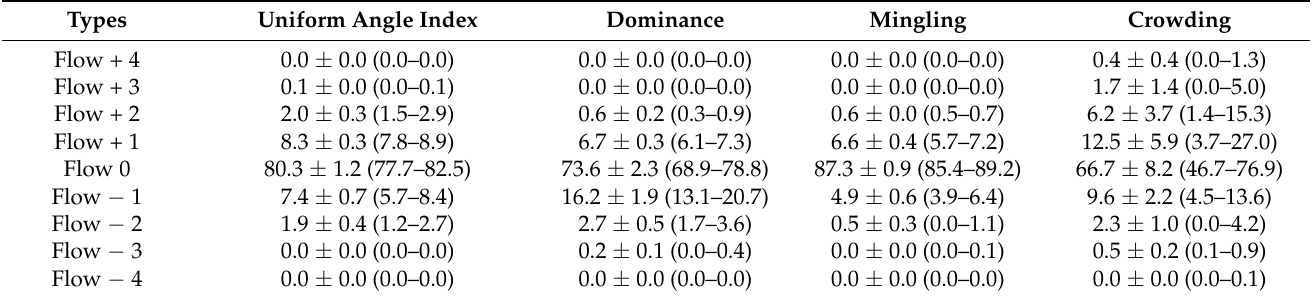
Table 2. The proportion statistics of change types in living trees’ flow (%).